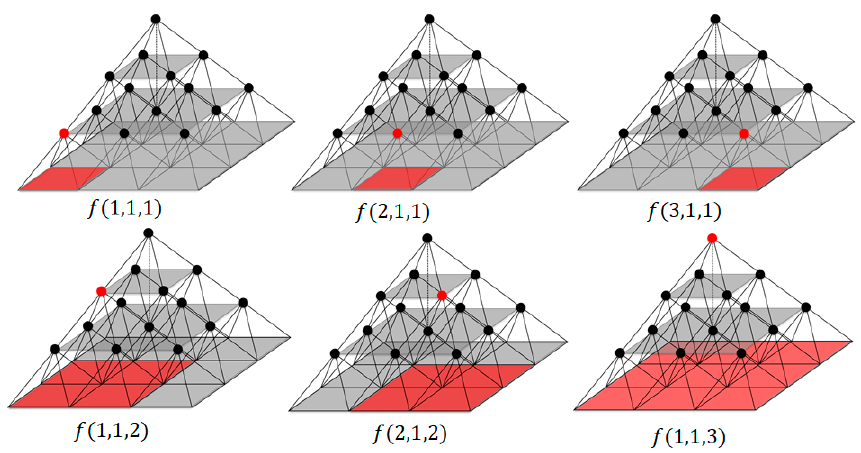
Figure 15. Representing square areas in different sizes as points in the 3D pyramid space.